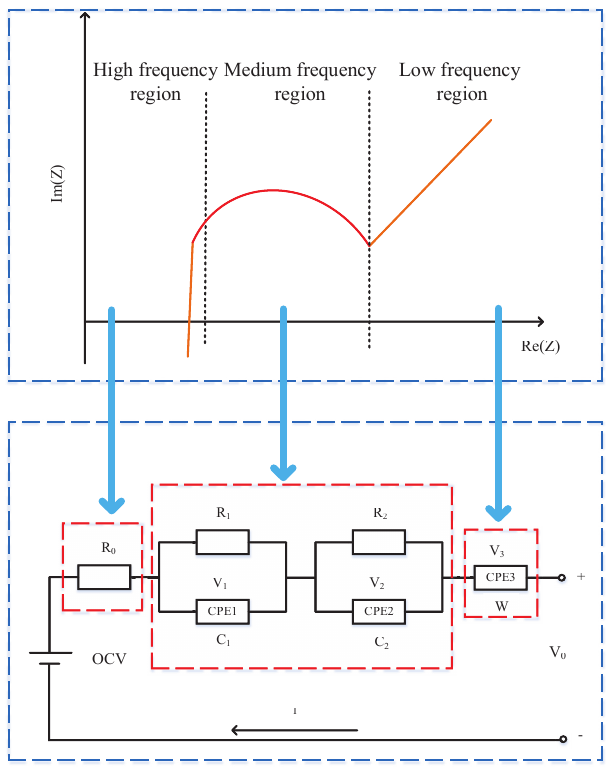
Figure 1. The EIS-FOM representation of